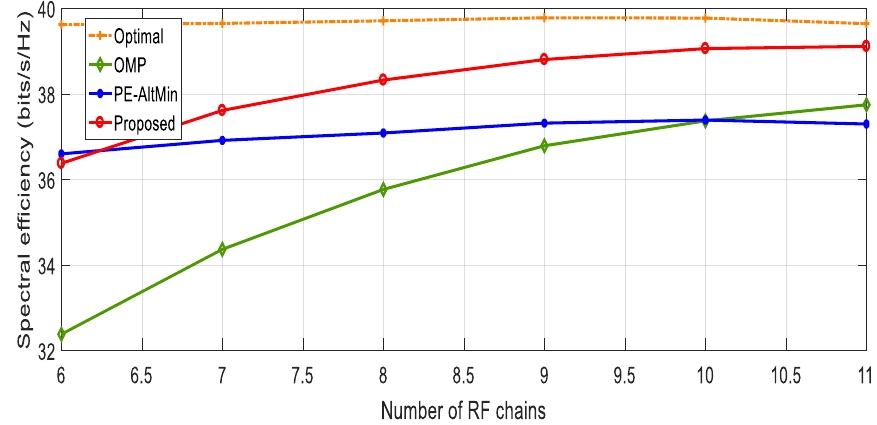
Figure 4. Spectral efficiency at 0 dB .